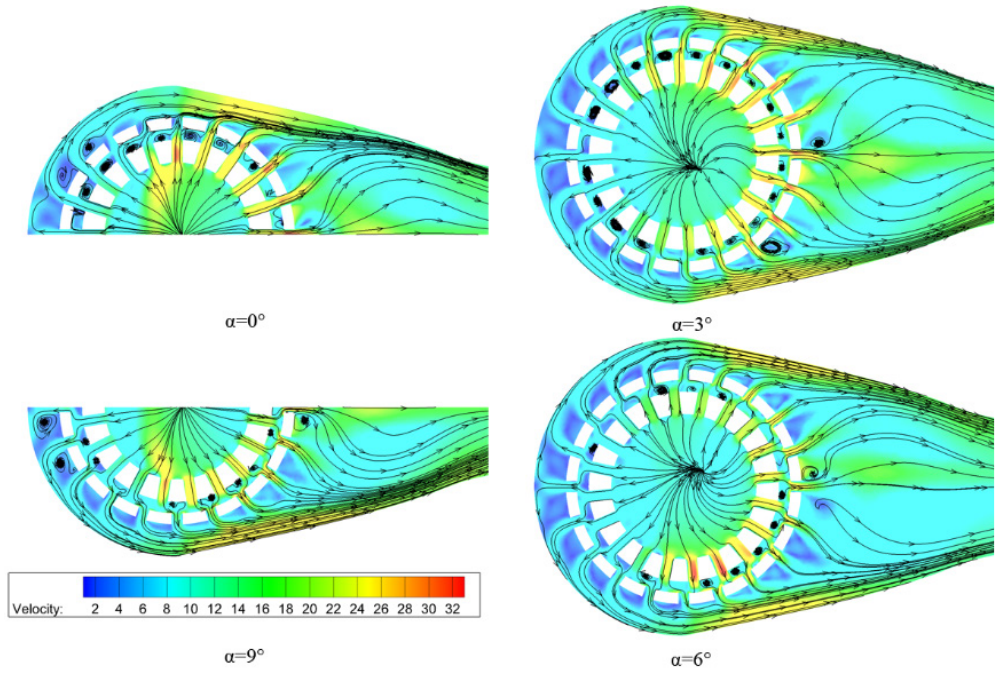
Figure 11. Streamline on a cross-section for the two-cage globe valve with different installation angles.